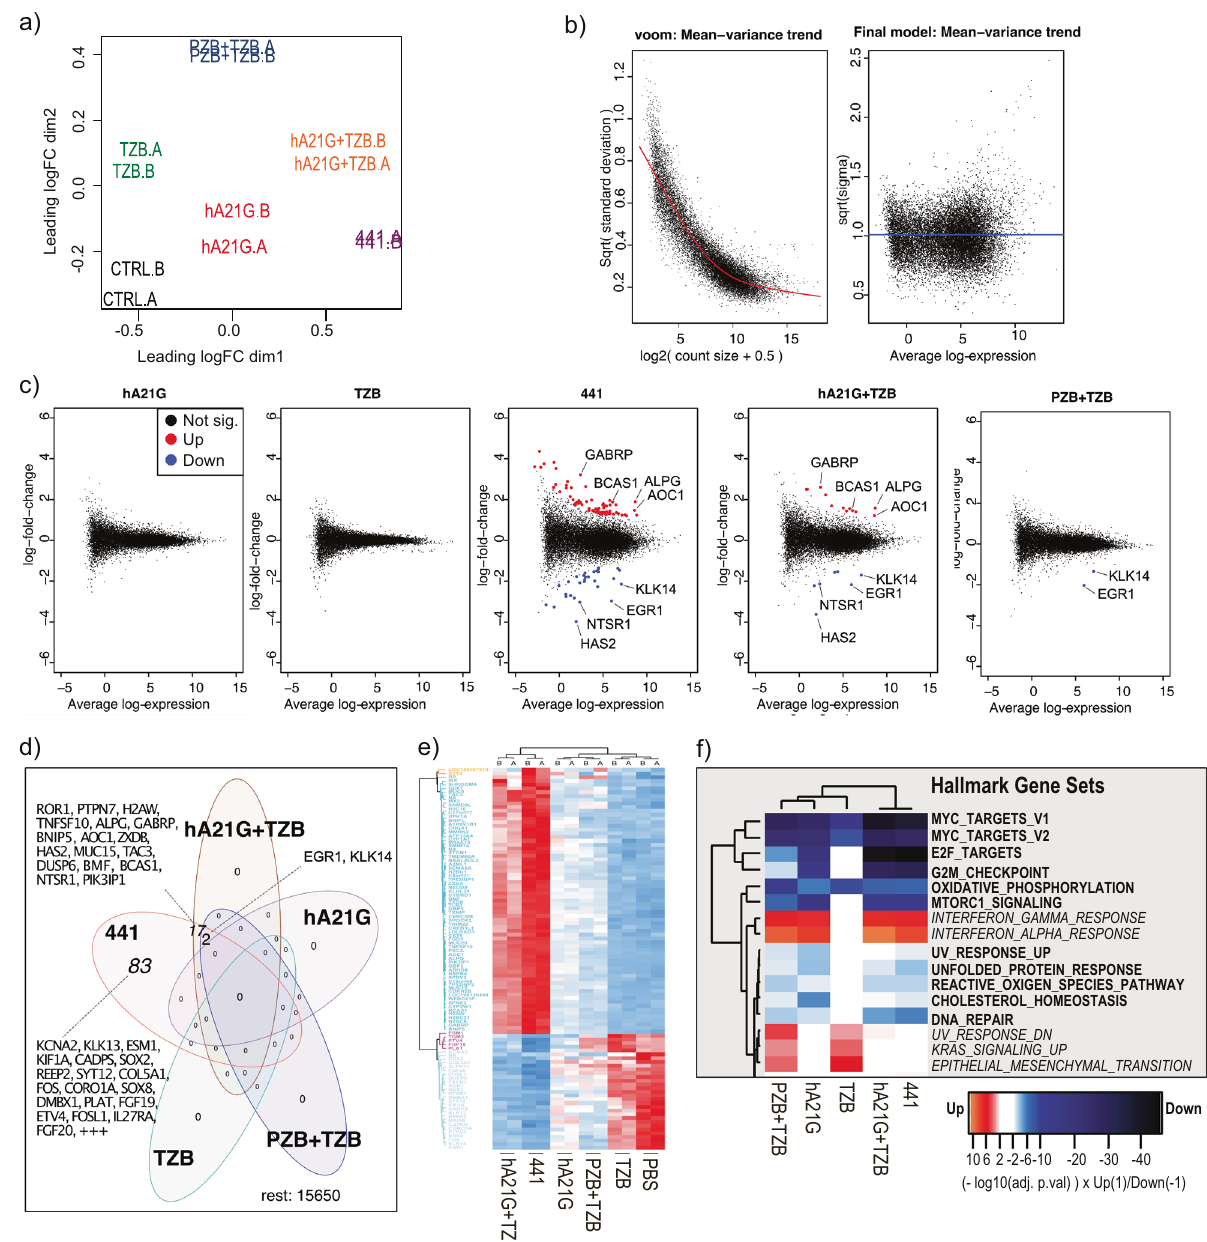
Fig. 7 Differential gene expression analysis in N-87 cancer cells after anti-HER2 treatments by RNA-seq reveals distinct gene up- and downregulation caused by 441. a MDS plot for indicated treatment in biological replicates (A/B). b Limma/voom fi t of log 2 transformed counts per million reads (CPM) and calculation of quality weights for individual samples. c MDplot of signi fi cant DEG ’ s versus PBS control treatment. d Venn diagram analysis of signi fi cant DEG ’ s with twofold change (log 2 FC > 1). e Euclidean clustered heat map based on z -scores of signi fi cantly regulated transcripts after the 441 treatment across all indicated treatments. f Euclidean clustered heat map of hallmark gene sets after indicated treatments. Note, adjusted p values were − log 10 - transformed and downregulated gene sets were multiplied by − 1 to account for negative effect. Source data are available in the Source Data fi